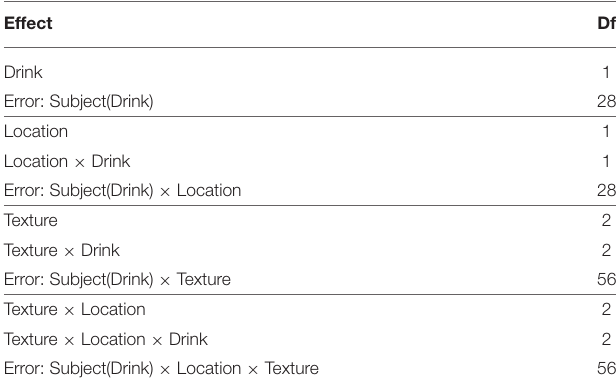
TABLE 7 | ANOVA table for the example 3-way mixed-measures